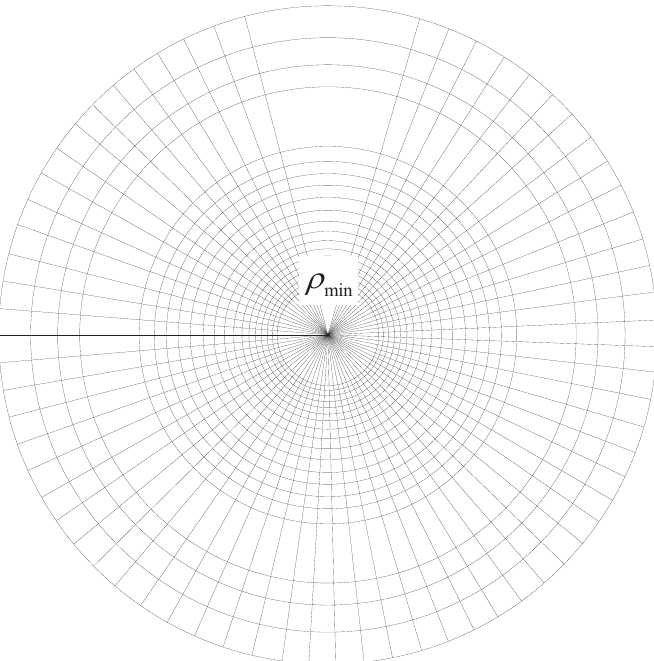
Figure 2. A circular square in a cluster. ρ min is the minimum radius within which there is no node